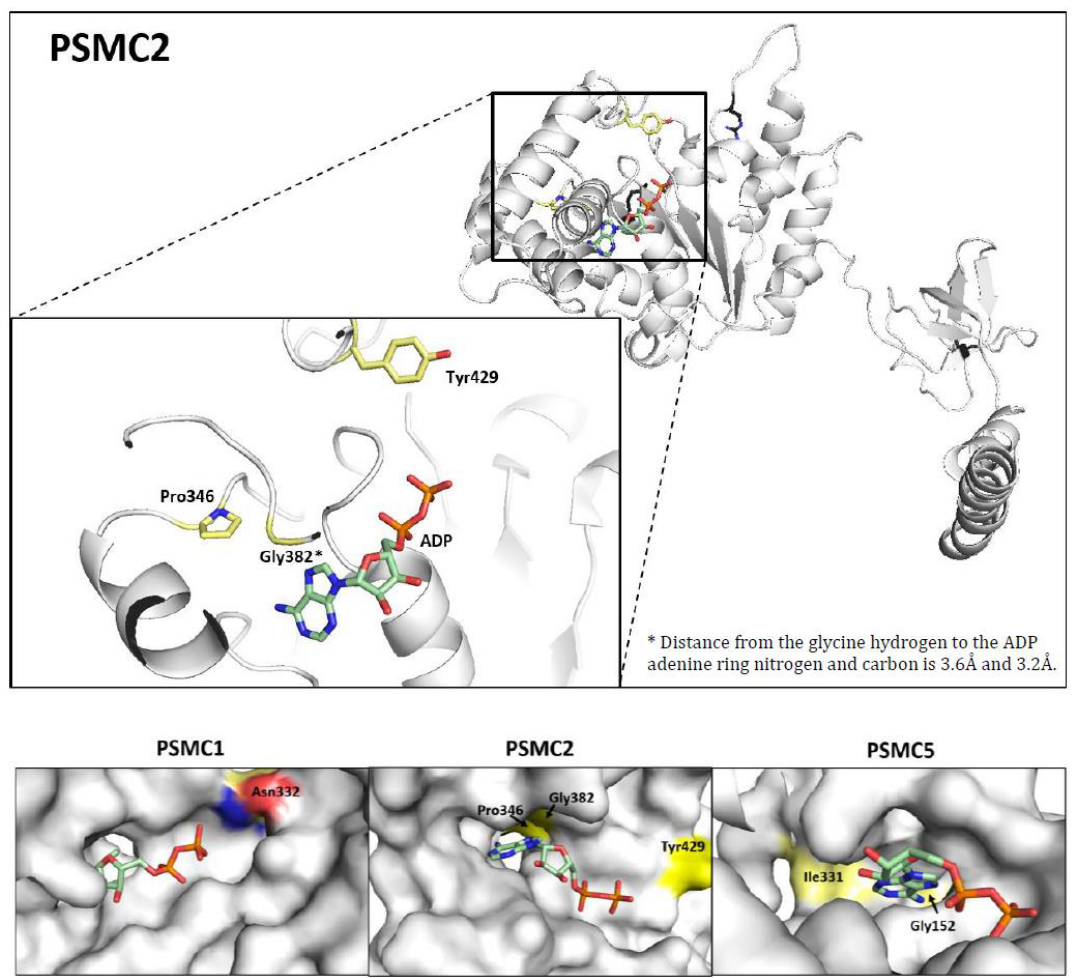
Figure 2. Amino acids with patient-derived mutations in proximity to the ATP/ADP pocket. PDB 5GJQ [39] analyzed with PyMol. The ADP is shown as wireframe stick in light green, and the endogenous amino acids where the patient-derived mutations were found are shown in light yellow, with red indicating a negative charge (oxygen) and blue indicating a positive charge (nitrogen).